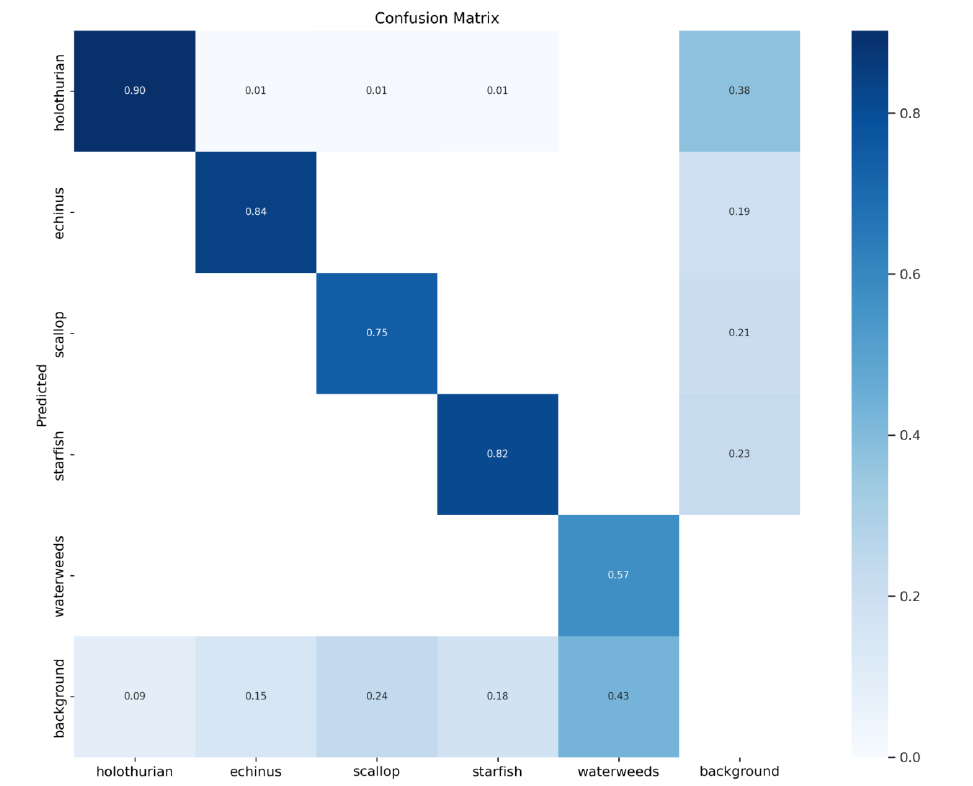
Figure 15. Confusion matrix for the proposed